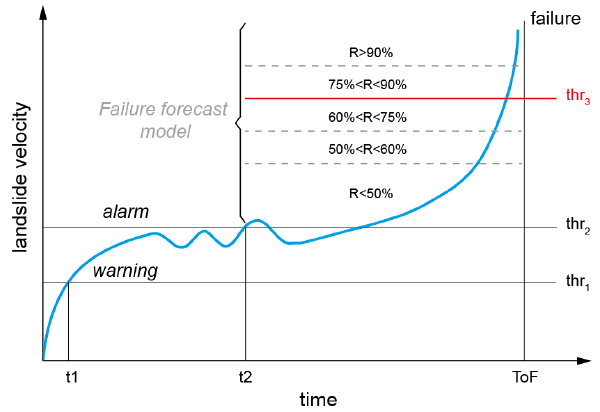
Figure 1. Schematic representation of the evolution over time of landslide velocity prior to a failure event, by considering materi- als behaving under creep conditions. The evolution towards fail- ure may have different phases characterized by non-linear accelera- tions. While thr 1 and thr 2 are static thresholds defined from a priori information on the landslide behavior, thr 3 is based on the results from the failure forecast modeling obtained in near real